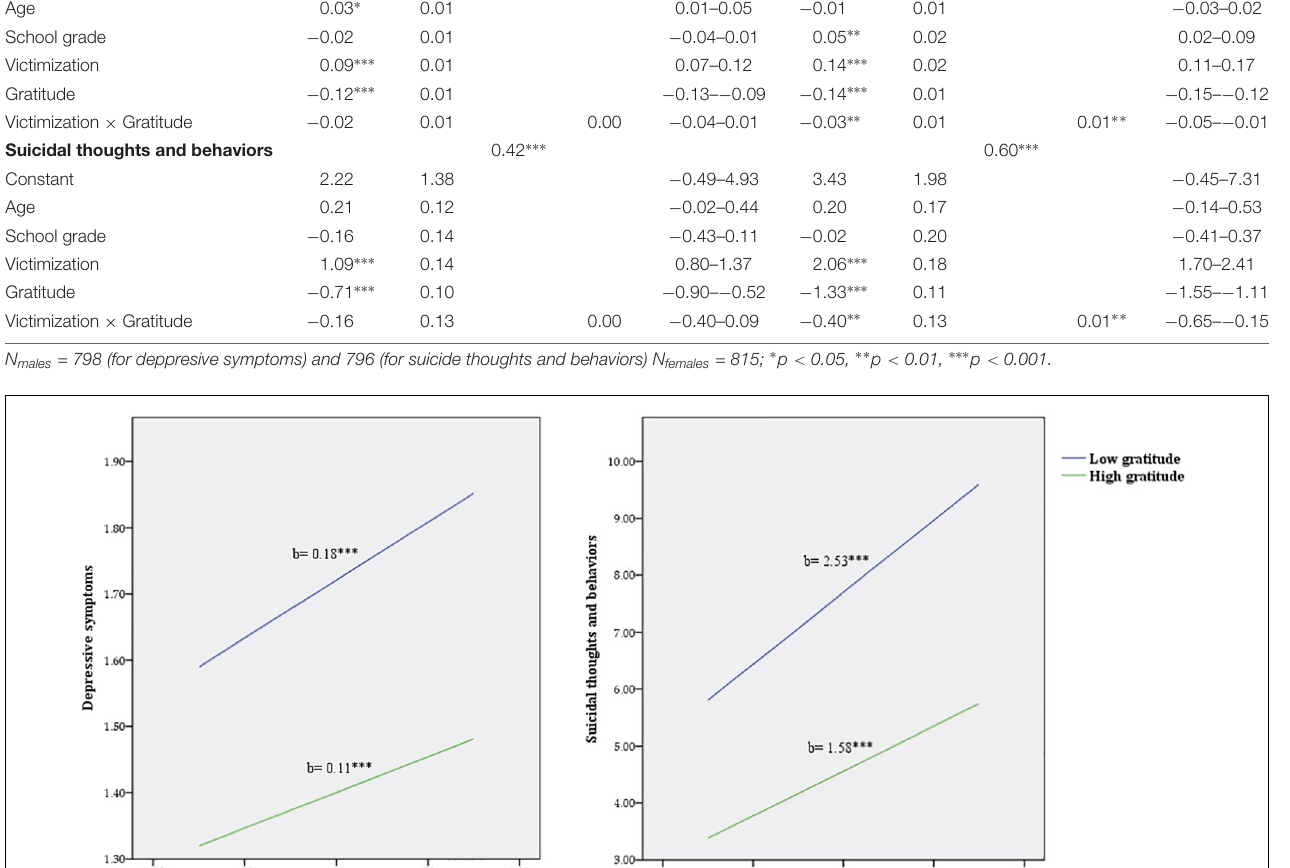
95% CI: − 0.15 to − 0.12, p < 0.01) and suicidal thoughts